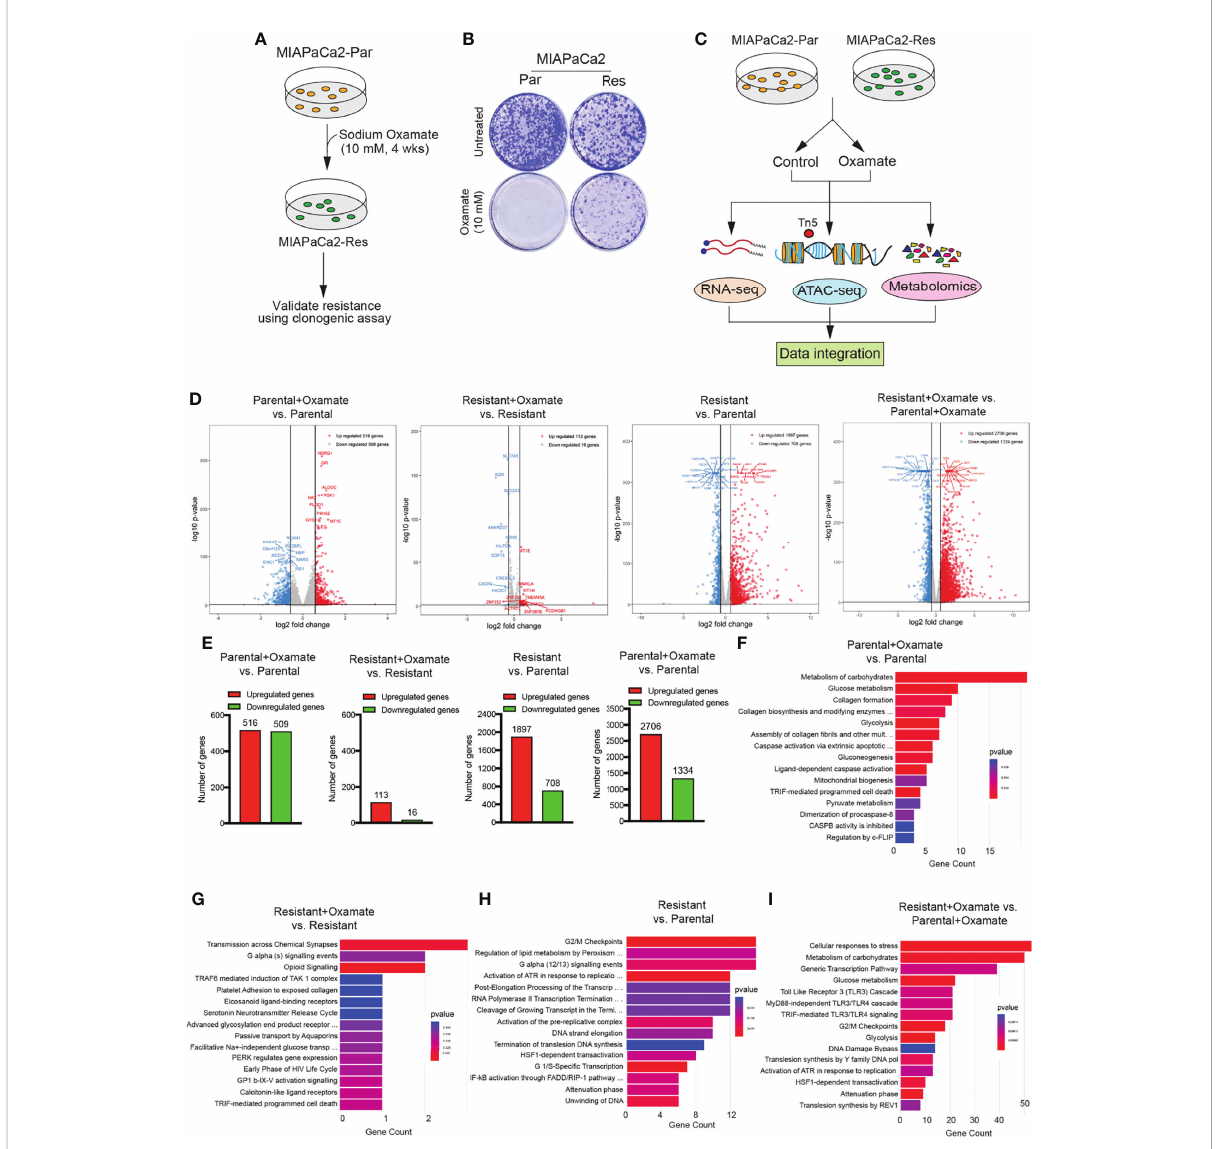
FIGURE 1 Generation of sodium oxamate – resistant cell lines and RNA-sequencing to identify differentially expressed mRNAs. (A) Schematic showing the steps used to generate and validate sodium oxamate – resistant MIAPaCa2 cells. (B) parental (Par) or sodium oxamate – resistant (Res) MIAPaCa2 cells were treated without or with 10 mM sodium oxamate (oxamate) for 2 weeks, followed by clonogenic assay. Representative colonies showing oxamate resistance are shown. (C) Schematic showing the pipeline for multiple unbiased omics approaches to determine the transcriptional, chromatin, and metabolic pro fi les of parental and oxamate-resistant MIAPaCa2 cells. (D) Volcano plot showing differentially expressed genes (up- or downregulated) in the indicated comparisons. The top 10 up- and downregulated genes based on p-values are also labeled. (E) Bar diagram showing the number of up- or downregulated mRNAs (genes) in the indicated comparisons. (F – I) Reactome Pathway Analysis showing key biological pathways associated with the differentially expressed mRNAs in the indicated